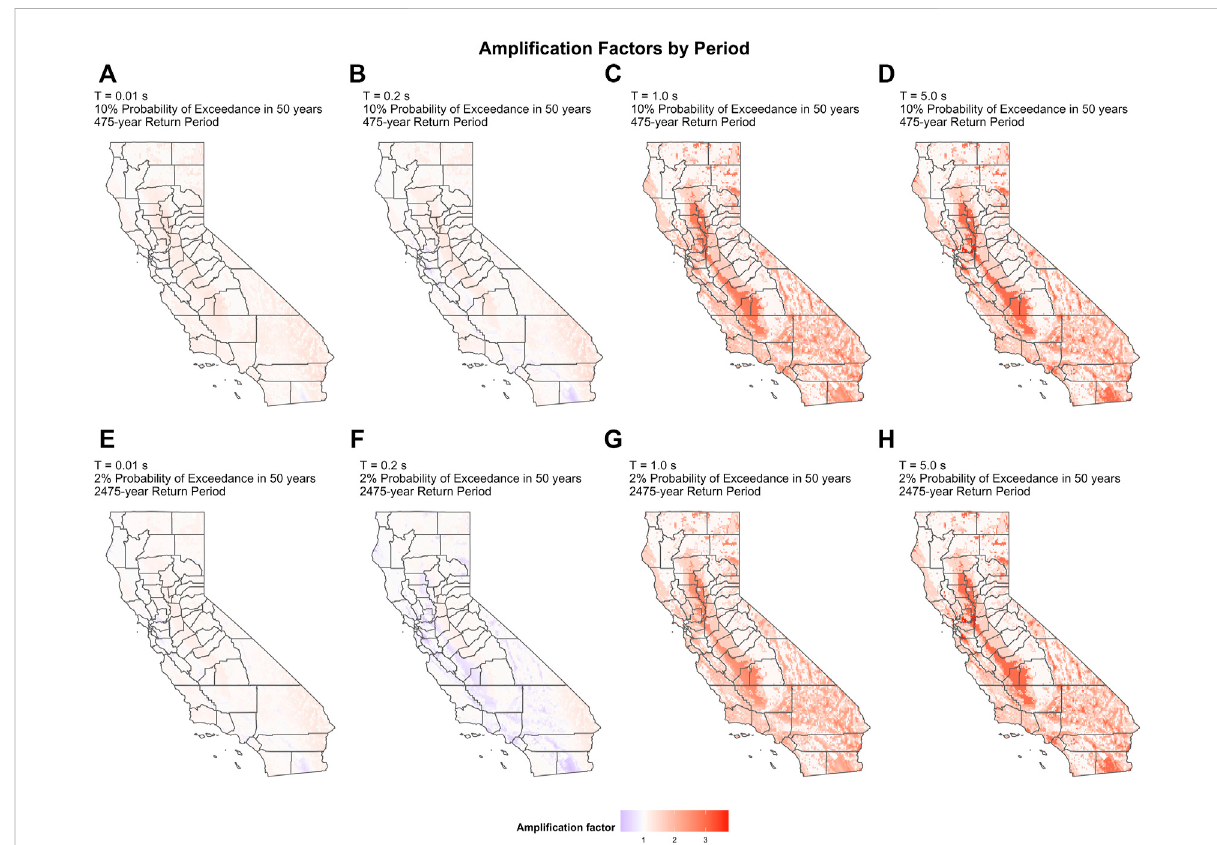
FIGURE 7 Ampli fi cation factors, as in Figure 3, relative to a reference V S30 = 760 m/s due to site-speci fi c V S30 for two hazard maps with different return periods and shaking with periods of 0.01 s (A,E) , 0.2 s (B,F) , 1.0 s (C,G) , and 5.0 s (D,H) . Only slight ampli fi cations arise in the PGA maps (A,E) . Appreciable ampli fi cations arise in longer-period maps (1.0 s and 5.0 s) because little to no nonlinear deampli fi cation occurs. Only linear ampli fi cation occurs for 5.0 s period, making (D) and (H) identical. Nonlinear effects are the strongest for spectral periods below 0.2 s (Yu et